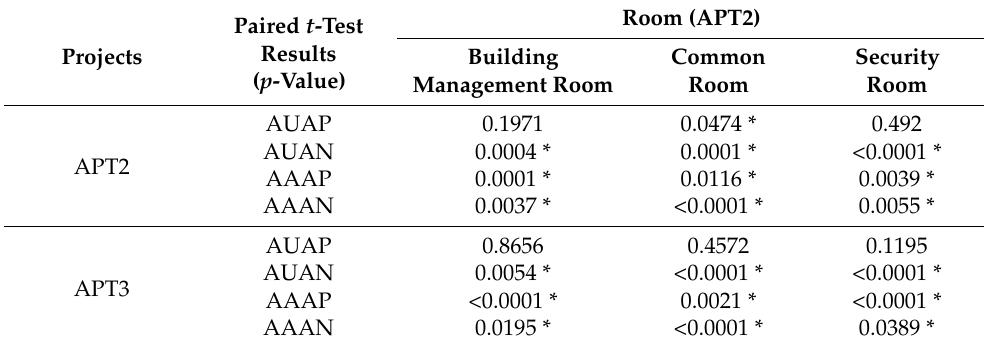
Table 16. Snapshot of p -values from paired t -test results in Room component at APT2 project.